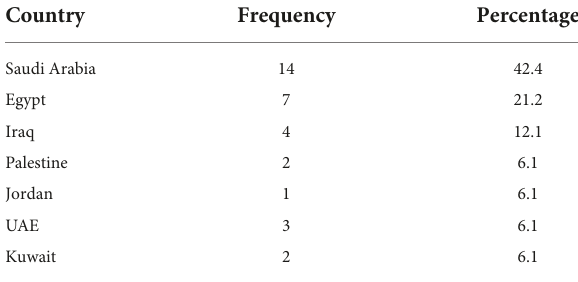
TABLE 5 Geographical distribution of research paper to uses of virtual and augmented reality in science and math education in Arab countries ( n =